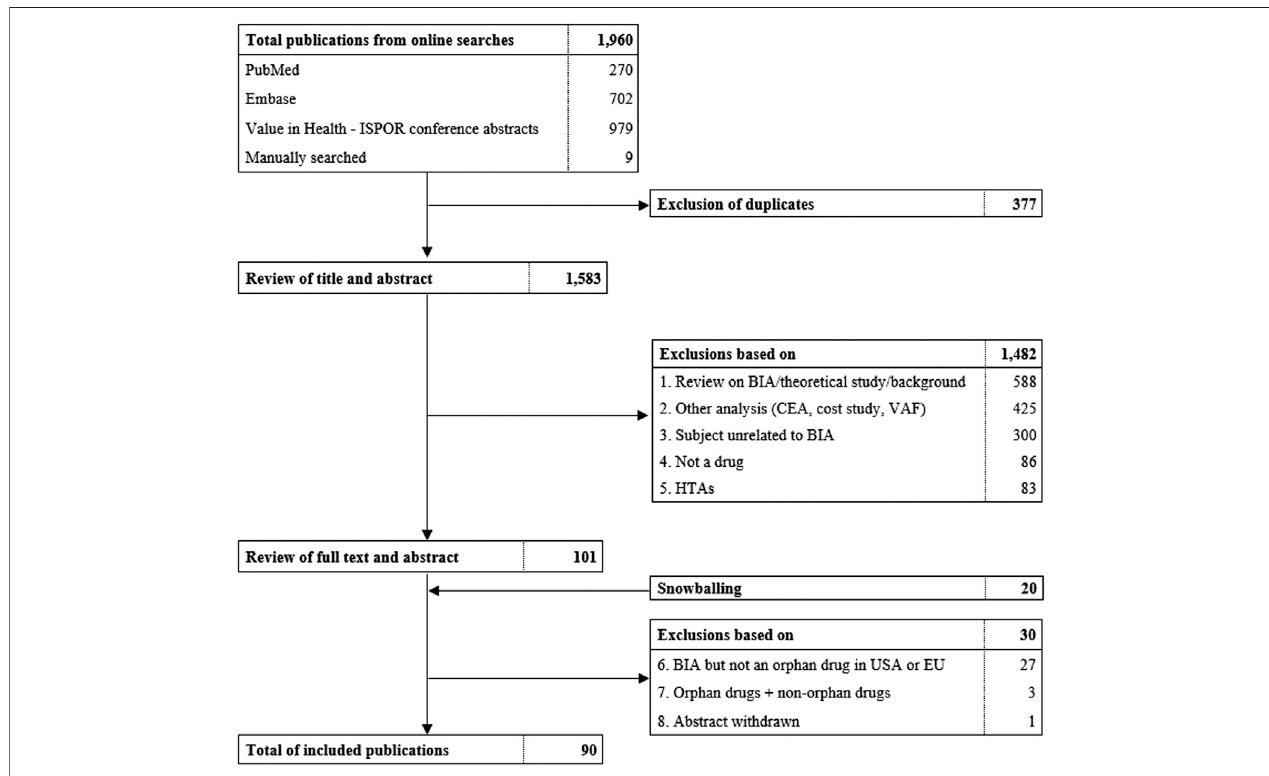
FIGURE 1 | Flowchart of literature search and selection of publications. ISPOR, International Society for Pharmacoeconomics and Outcomes Research, BIA, budget impact analysis. CEA, Cost-ef fi ctiveness analysis. VAF, value assessment framework. HTA, health technology assessment.